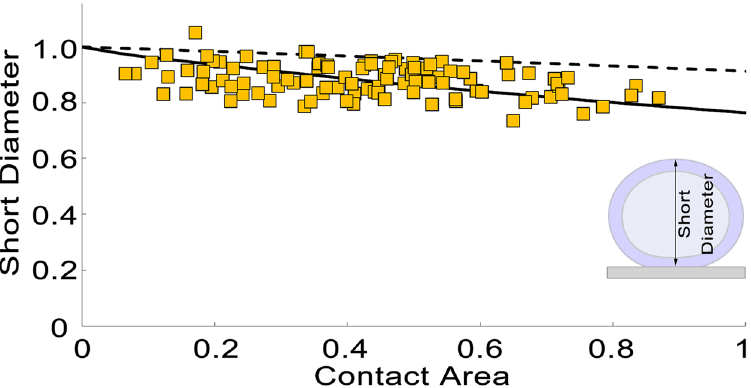
Figure 6. Relationship of an SV’s short diameter with the SV’s contact area at resting active zones of frog’s neuromuscular junctions. Contact areas of 101 docked SVs with the PM at active zones from resting frog’s neuromuscular junctions are plotted against their measured short diameters. The contact area of the docked SVs is correlated with the short diameter of the SVs (Pearson correlation, r = − 0.33, and p = 6.8 × 10 –4 ). The inset diagram shows the length and orientation of the short diameter for a docked SV. The dotted black line represents an expected relationship of each SV’s contact area with its short diameter from our simulated SVs assuming each SV has a shape of a spherical cap after docking with the PM, and it does not agree with the data. The solid black line is generated from a simple continuum model for docked vesicles assuming the axisymmetric shape and constant surface area of each vesicle and that the vesicle’s elastic energy is equal to the membrane bending energy (see Supplementary Material). The black line shows a significantly improved agreement with the measured relationship of the contact area with the short diameter from the 101 docked SVs 4